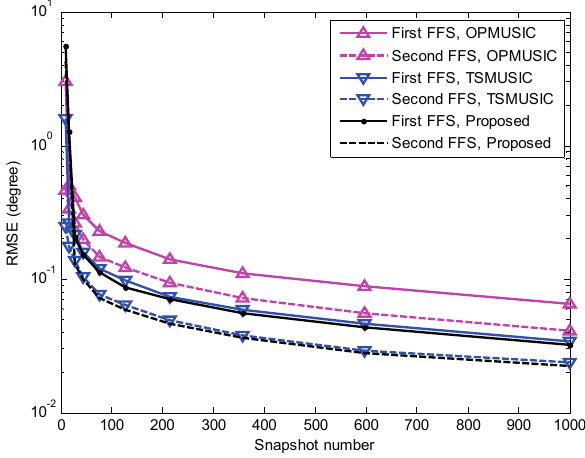
Figure 8. RMSEs of NFSs DOA estimates versus snapshot number. 500 independent trials are realized for each of the three methods.